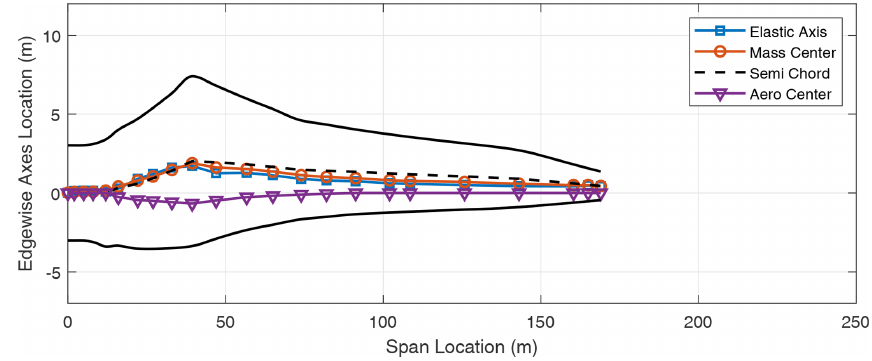
Figure A13. Planform for the SUMR25 turbine blade.